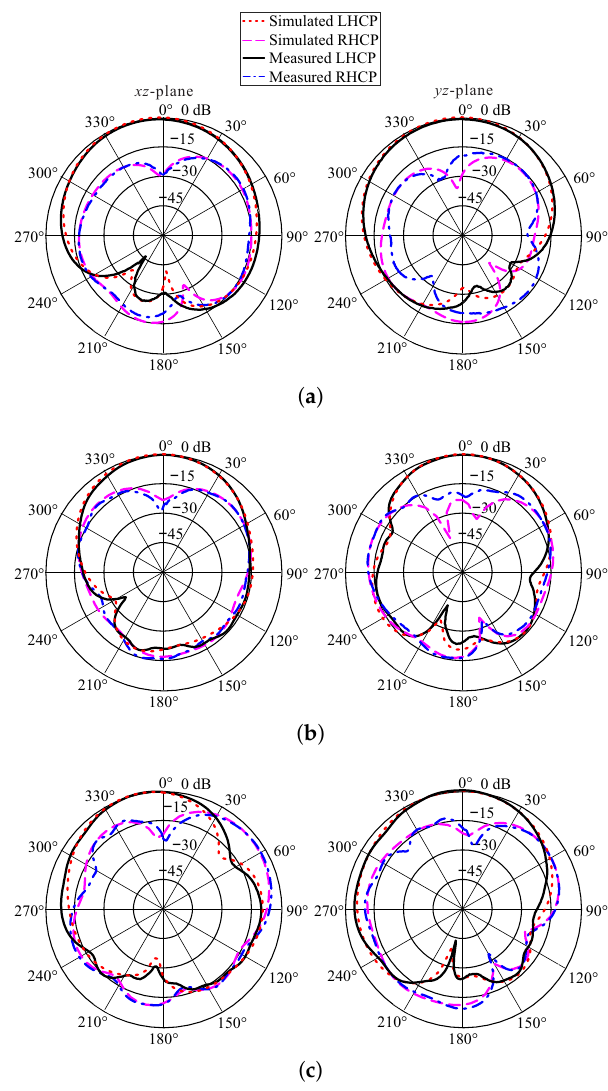
Figure 10. Measured and simulated normalized radiation patterns of the proposed antenna at ( a ) 2.36 GHz; ( b ) 3.18 GHz; and ( c ) 3.46